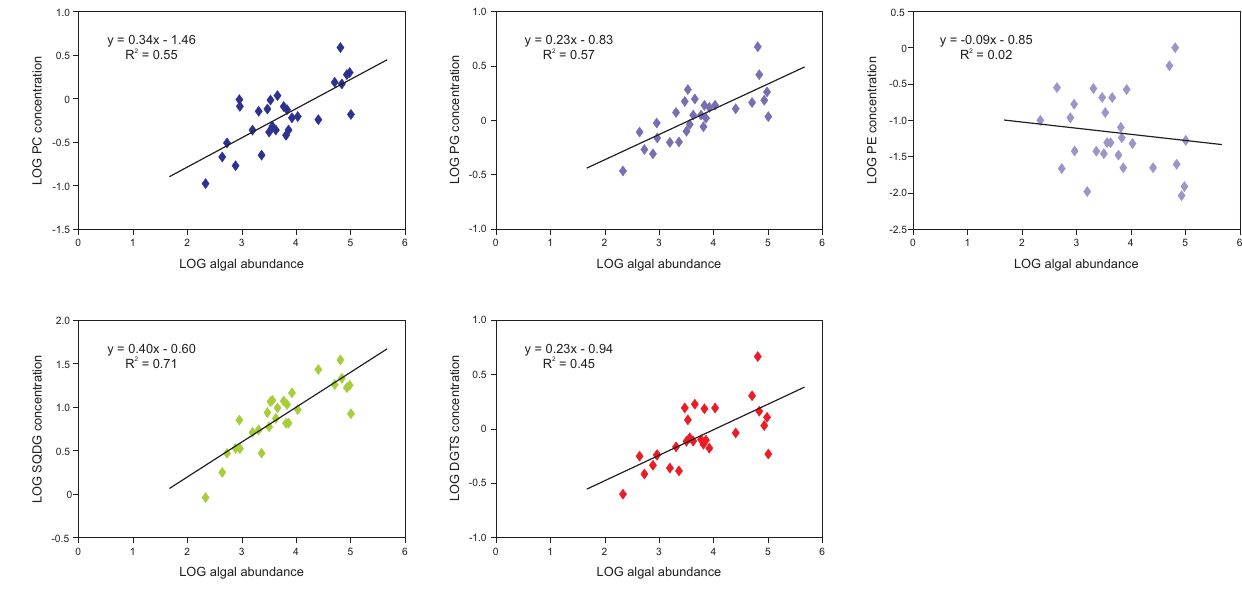
Fig. 5. Correlation plots between algal abundances and IPL concentrations in the Marsdiep.